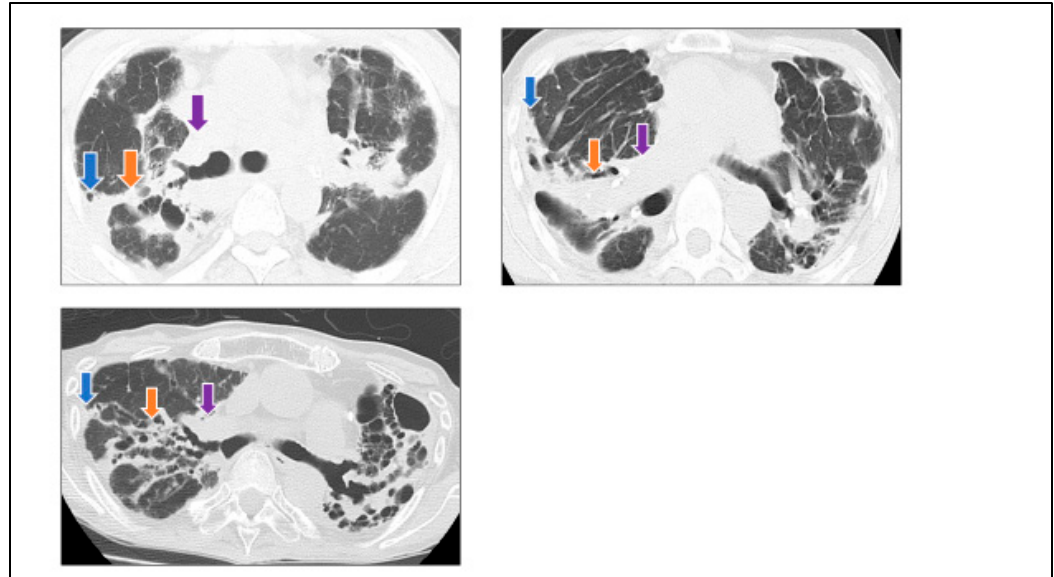
Figure 1. ‘Central-peripheral band’. In this study, we defined areas of consolidations around the bronchovascular bundle that progress towards the mediastinum (purple arrows: central consolidation) and pleura (blue arrows: peripheral consolidation) as ‘central-peripheral band’ (orange arrows). In addition, lesion volume was estimated and graded in 5% increments from 0% (absent) to 100% (whole lung). The degrees of calcification of lymph nodes were semi-quantitatively graded as 0 (absent), 1 (mild), 2 (moderate), or 3